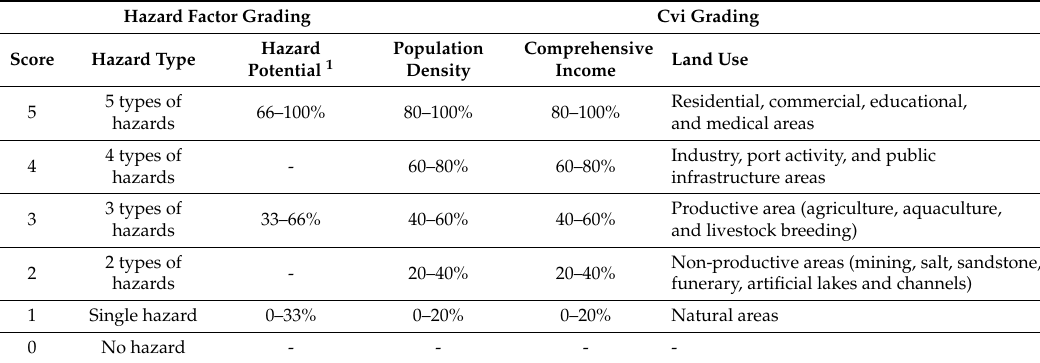
Table 2. Classification of hazard factors and